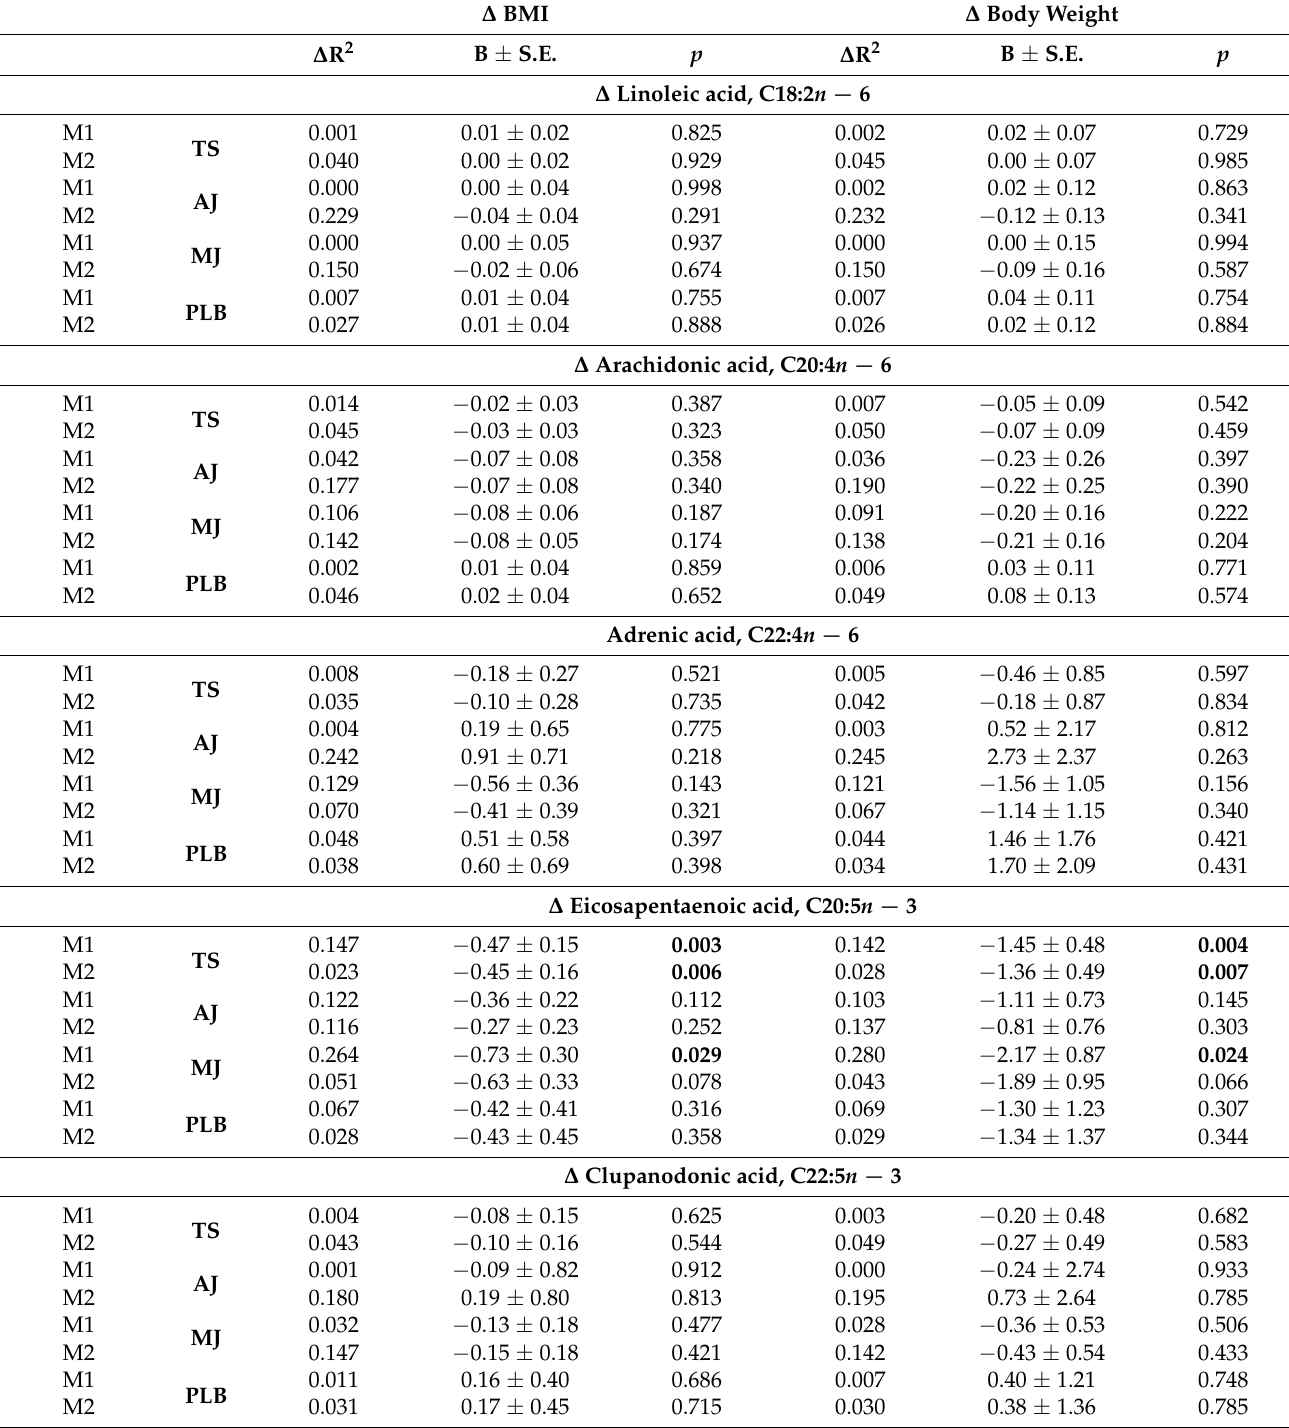
Table 2. Relationship between changes in long-chain polyunsaturated fatty acids in plasma phospholipids with BMI and total body weight in subjects who are overweight (BMI ≥ 25), across the study intervention groups with varying polyphenol